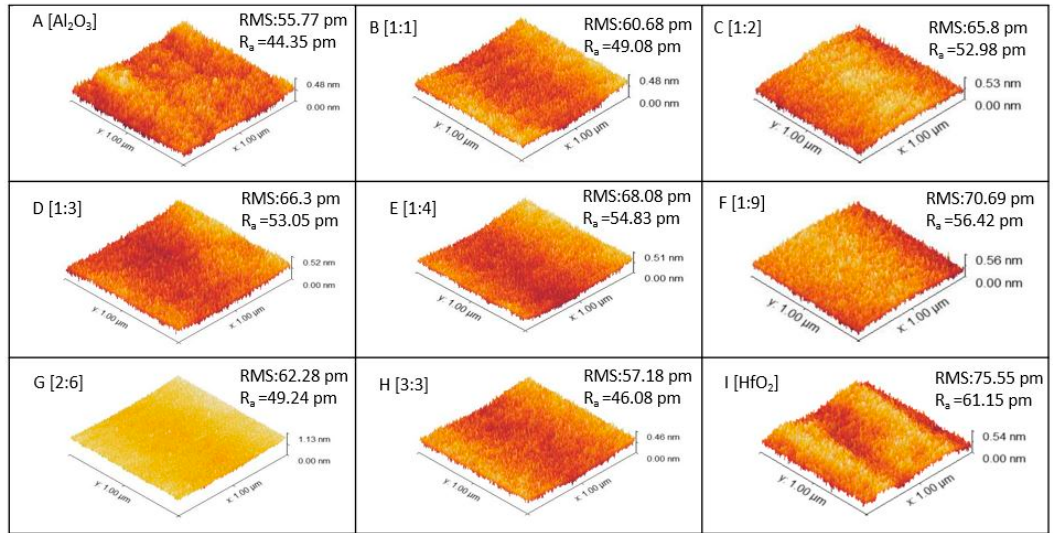
Figure 4. 3D AFM images for the HfAlO samples, along with Al 2 O 3 and HfO 2 stacks. AL incorporation into HfO 2 provides a smoother surface.